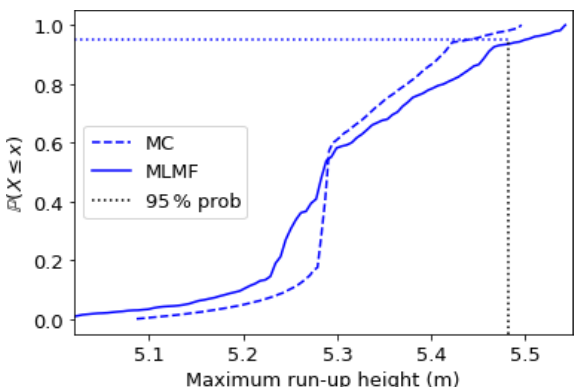
Figure 19. CDFs generated from MLMF outputs using the mod- ified inverse transform sampling method (Eq. 17) compared with those generated using Monte Carlo (MC) outputs, for the Carrier– Greenspan test case.